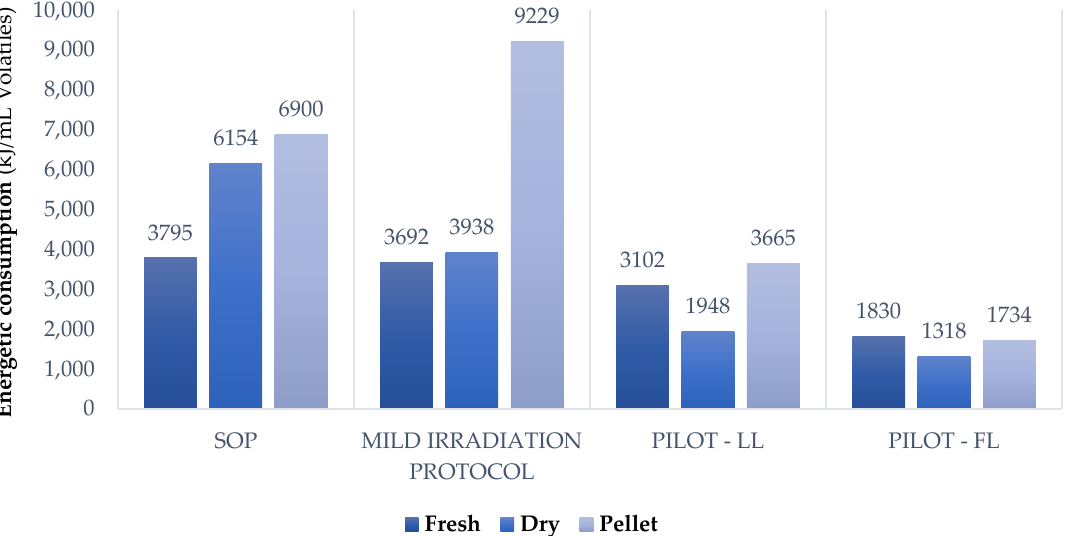
Figure 7. Energy consumption comparison. Chiller systems are computed.